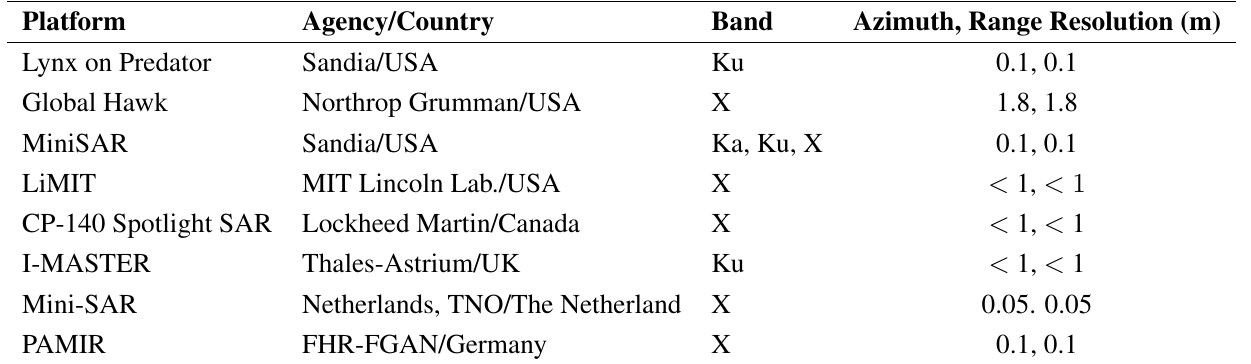
Table 4. Examples of airborne/UAV-borne SAR platforms equipped with SpotLight mode. Platform